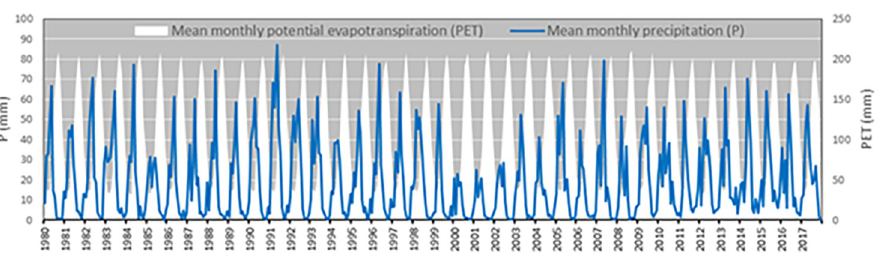
Fig 2. Mean monthly P (left axis) and PET (right axis) time series at national scale over the study period 1980–2017.